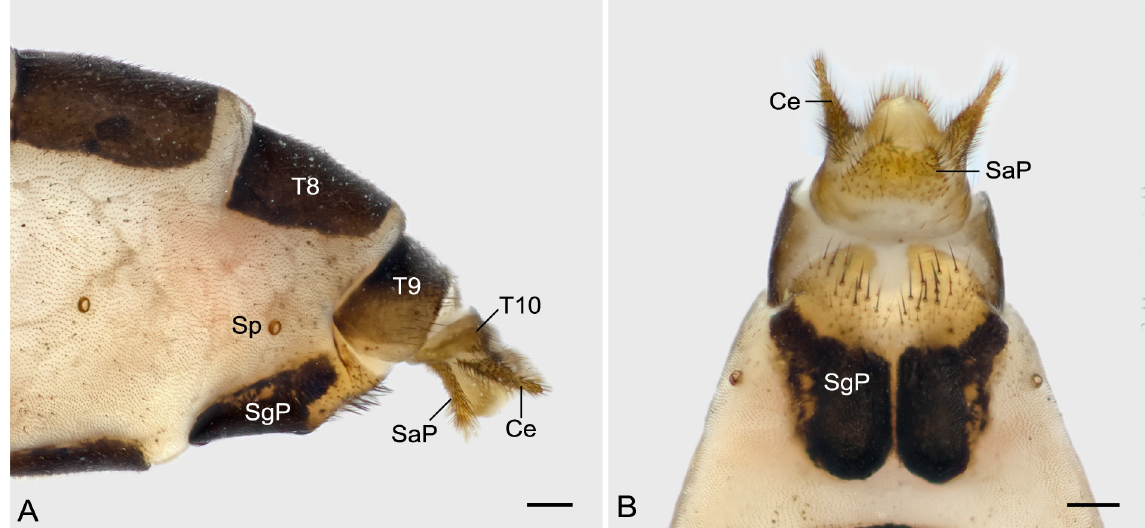
Fig. 4. Female terminalia of Terrobittacus rostratus sp. nov. A . Lateral view. B . Ventral view. Abbreviations: Ce = cercus; SaP = subanal plate; SgP = subgenital plate; Sp = spiracle; T = tergum. Scale bars = 0.2